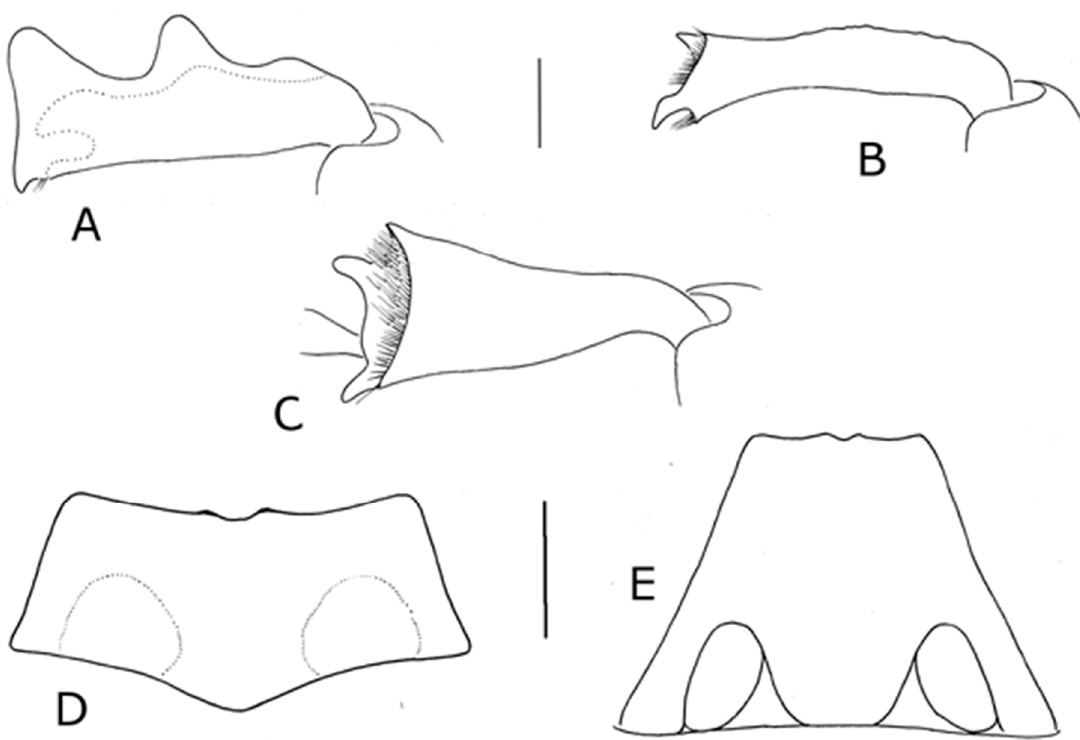
Figure 12. Sclerocardius bohemani Schoenherr: ( A ) fore tibia, right (dotted line indicates smooth asetose areas), ( B ) Mid tibia, right anterior (setae omitted other than on premucro and apical comb), ( C ) hind tibia, right anterior, ( D ) tergite VII, male, and ( E ) tergite VII, female. Scale bars = 1 mm. Male genitalia. Sternite VIII with two very weakly sclerotised lobes posteriorly, anterior margin of sclerite tri-concave (Figure 13A). Spiculum gastrale Y-shaped, simple (Figure 13B). Tegmen with apodeme short, asymmetric (Figure 13C). Penis (Figure 13D,E) body half length of its apodemes, length not more than 2.1 times its maximum width; fully sclerotised; dorsally weakly concave; sides